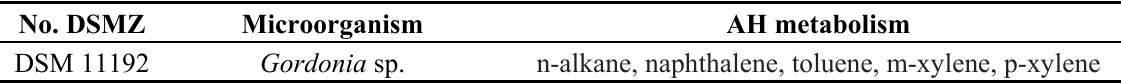
Table 2. Positive standard utilized in the